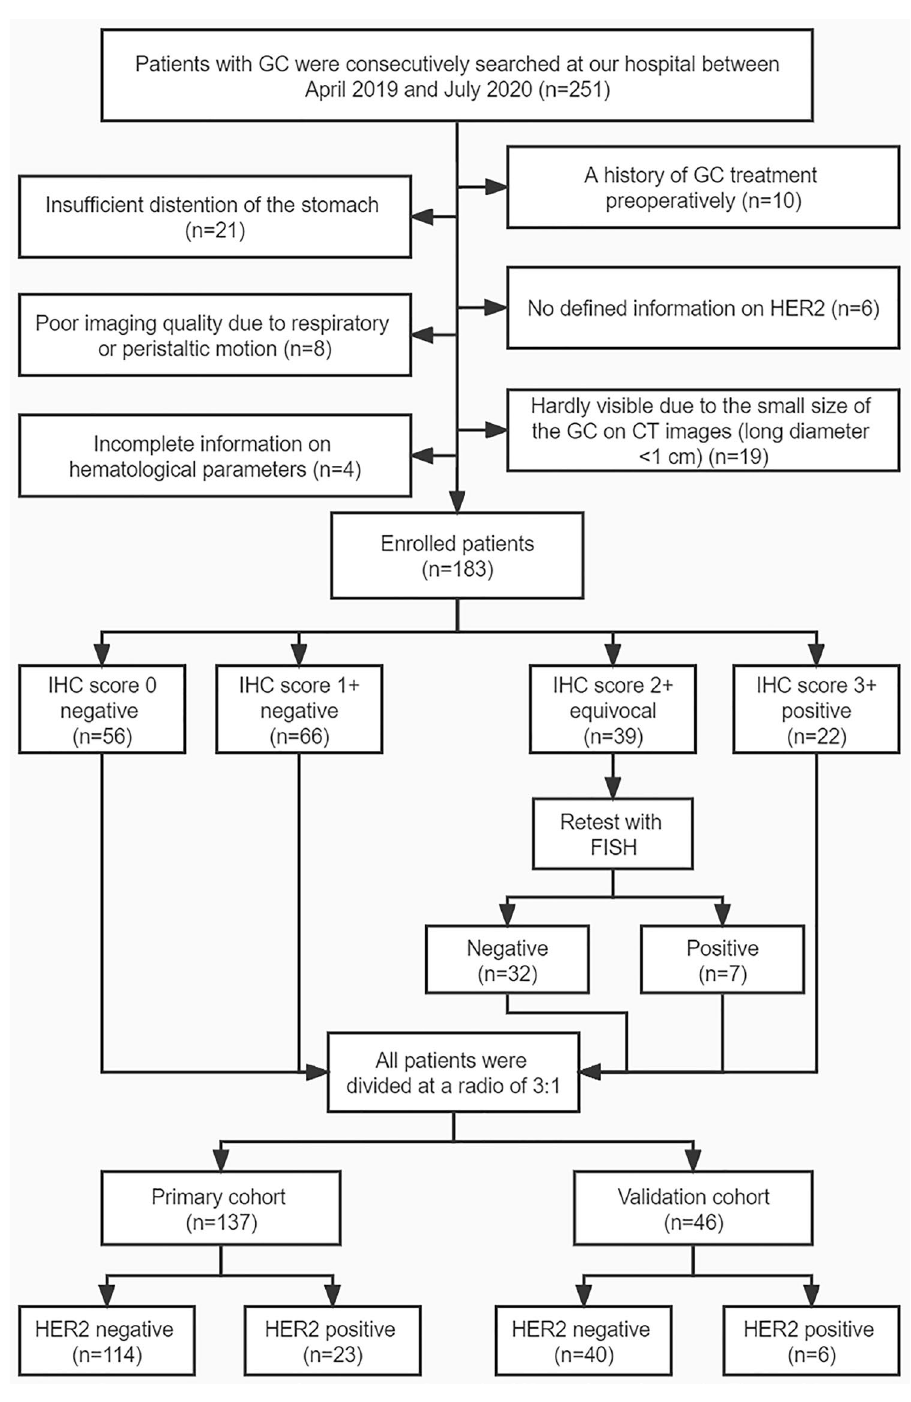
Figure 1. The flowchart of the enrolled patients in this study. GC gastric cancer, CT computed tomography, HER2 human epidermal growth factor receptor 2, IHC immunohistochemistry, FISH fluorescence in situ